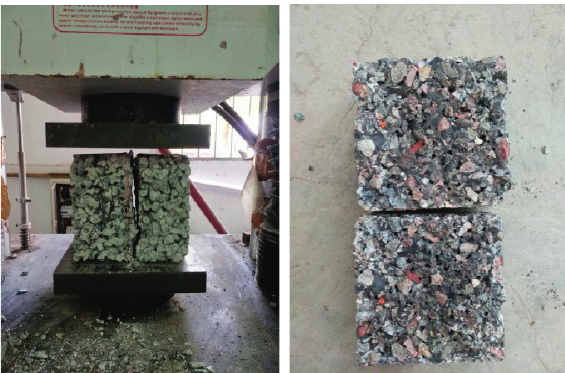
Figure 7: Damage pattern of RAPC under splitting